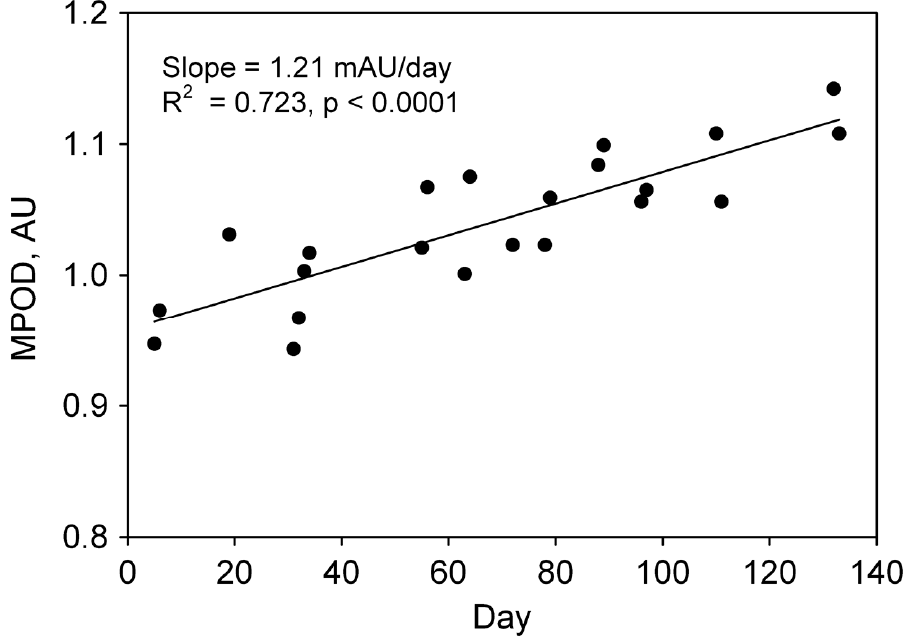
Figure 3. Serum lutein and macular pigment optical density (MPOD). Rate of change of MPOD (milli-Absorbance units) as a function of fractional change in serum lutein concentration (plateau value minus pre-supplementation value, divided by pre-supplementation value). Data from 46 healthy subjects randomly assigned to 0, 5, 10, and 20 mg of free, unesterified lutein in soft-shell gelatin capsules and whose standard deviations in the rates of change of MPOD were <0.250. From [83]. MPOD is related to static indicators of visual performance, such as glare and contrast sensitivity, and dynamic measures of visual performance such as the critical flicker fusion threshold [84–86]. MPOD is also related to measures of cognitive function such as verbal fluency, memory, processing speed and accuracy [76]. MPOD was significantly associated with select auditory thresholds in young healthy adults [87]. Elevated lutein and zeaxanthin status appears to be associated with diminished risk of cataract [88]. While supplementation with 10 mg lutein and 2 mg zeaxanthin had no effect on advanced age-related macular degeneration (AMD) risk in AREDS, subgroup analysis showed a beneficial effect in patients with the lowest baseline intake of these carotenoids [89]. A recent systematic review and meta-analysis of six longitudinal cohort studies concluded that dietary intake of lutein and zeaxanthin was not significantly associated with a decrease in risk of developing early AMD but an increased intake of these carotenoids may be protective against late AMD [90]. A meta-analysis of 22 publications found a positive correlation of MPOD with measures of visual function, i.e., contrast sensitivity, photostress recovery, and glare disability [91]. A steroidogenic acute regulatory family protein, i.e., StARD3, has been identified in primates and subsequently identified as a human retinal lutein-binding protein [92]. In summary, there is evidence to support the promulgation of lutein DRI to achieve MPOD levels that are associated with healthy visual and brain